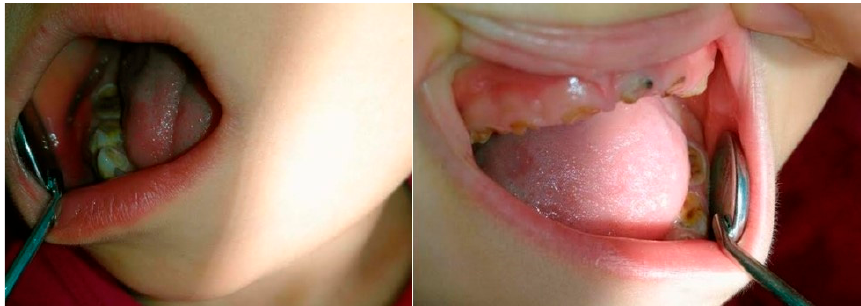
Figure 2. Five years and 7-month year old boy, presenting dmft score 20.